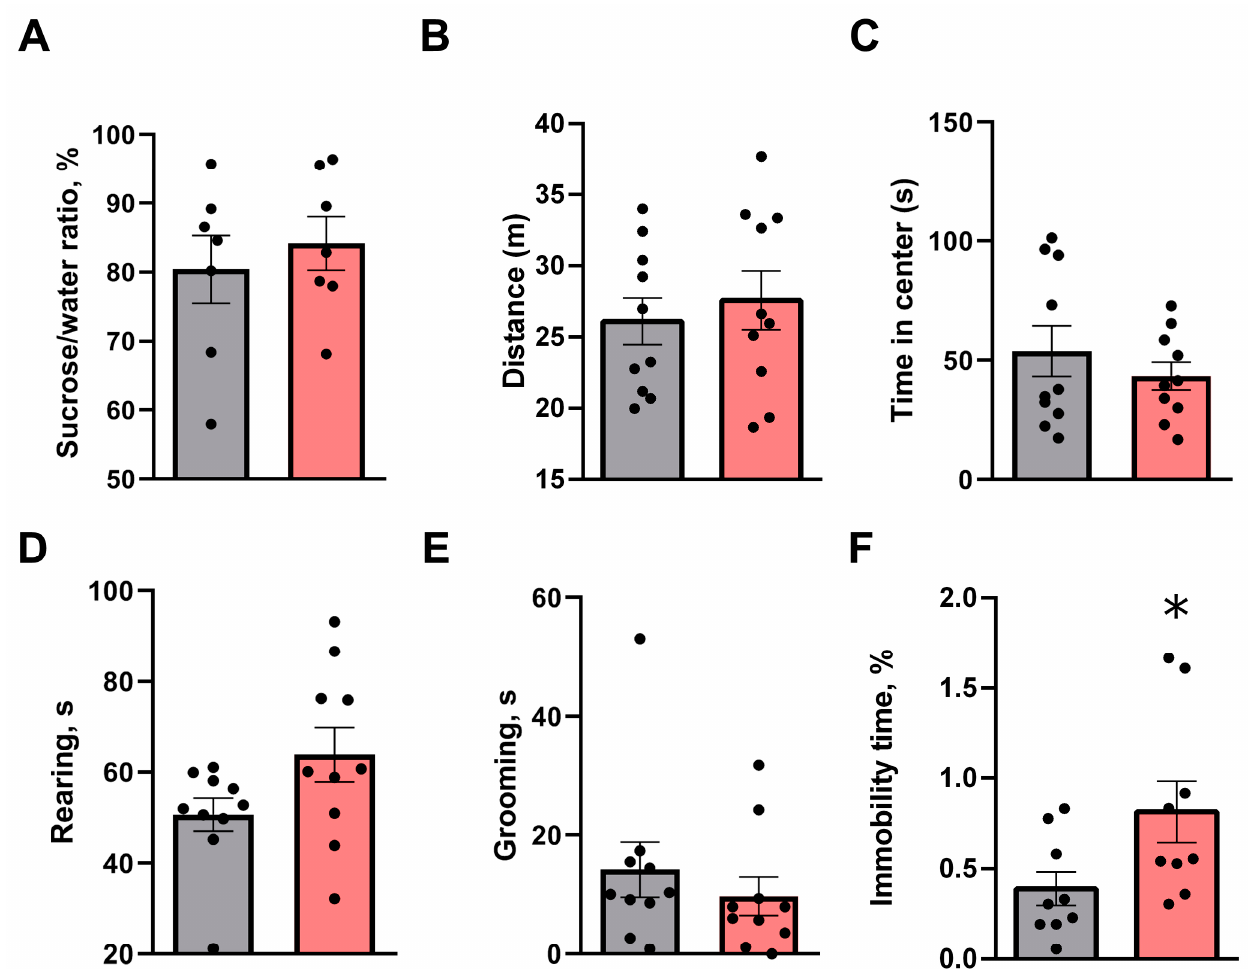
Figure 3. Behavioral consequences of single social defeat stress exposure. Rats were tested in the standard battery of behavioral assessments, including a two bottle choice, open field and forced swim tests. ( A ) Sucrose preference (n = 7 per group), ( B – E ) locomotor and anxiety-like behaviors (n = 10 per group) and ( F ) floating behavior (n = 9 per group) were evaluated 24 h following social defeat or control condition procedure. Grey bars–control rats; Red bars–defeated rats. All data presented as mean ± SEM. Unpaired two-tailed t -test or Mann–Whitney U test was used, * p = 0.0427. Administration of the selective D2 dopamine receptor antagonist raclopride (2 mg/kg, i.p.) resulted in significant increase of electrically evoked dopamine release in both groups (repeated measures two-way ANOVA; F (8, 88) = 30.26; p < 0.0001), while a greater effect was observed in controls compared to defeated rats (F (1, 11) = 5.321; p < 0.05) (Figure 6). Following the dopamine depletion protocol, both groups showed a similar dramatic reduction in electrically evoked dopamine efflux (repeated measures two-way ANOVA; F (21, 210) = 14.76; p < 0.0001) with no difference between groups (F (1, 10) = 1.141; p > 0.05) (Figure